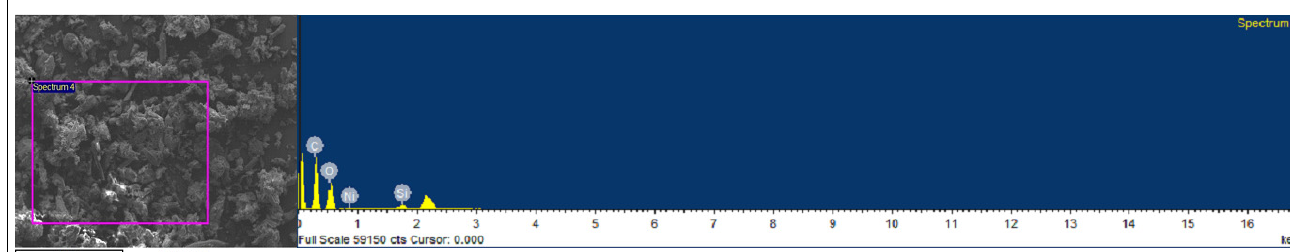
Figure 5. SEM − EDX spectra of impregnated sample. Figure 5. SEM-EDX spectra of impregnated sample.